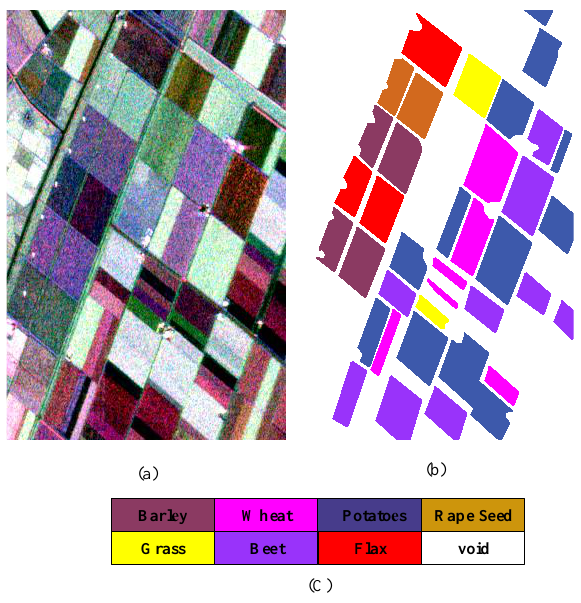
Figure 5. Fle1991. ( a ) Pauli RGB image. ( b ) GT. ( c ) Color